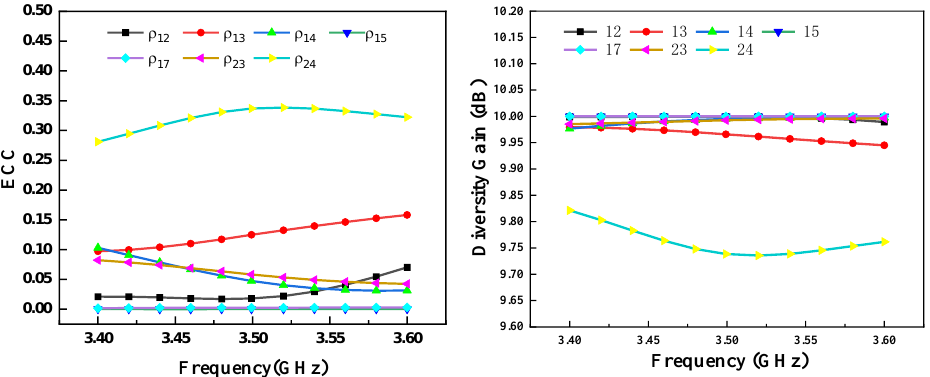
Figure 12. ECC and diversity gain of the 8 × 8 MIMO antenna.